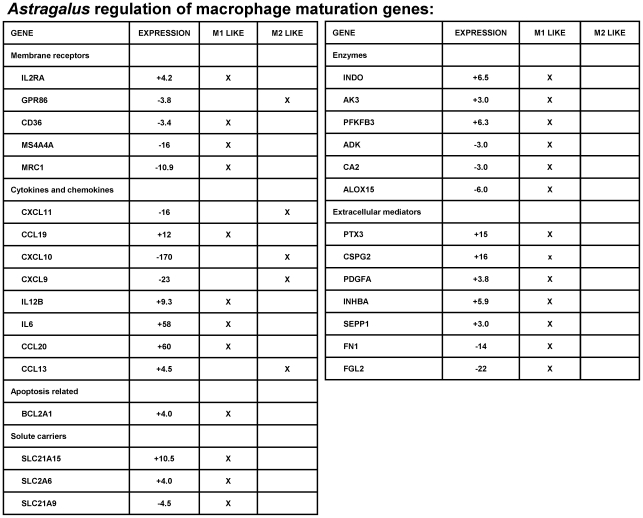
Transcriptional profiling of M1/M2 macrophage polarization induced by Astragalus membranaceus.
Human genes involved in defining M1/M2 polarization are shown [47]. The transcriptional regulatory effect of each gene following treatment of PBMCs with Astragalus extract is indicated (‘Expression’ column), with positive values representing increased expression, and negative values representing repressed expression. The ‘X’ (in the ‘M1 like’ or M2 like' column) indicates that the change in gene expression (induced or repressed) following Astragalus treatment was similar to that previously observed following monocyte maturation to either an M1-like or M2-like macrophage polarization.